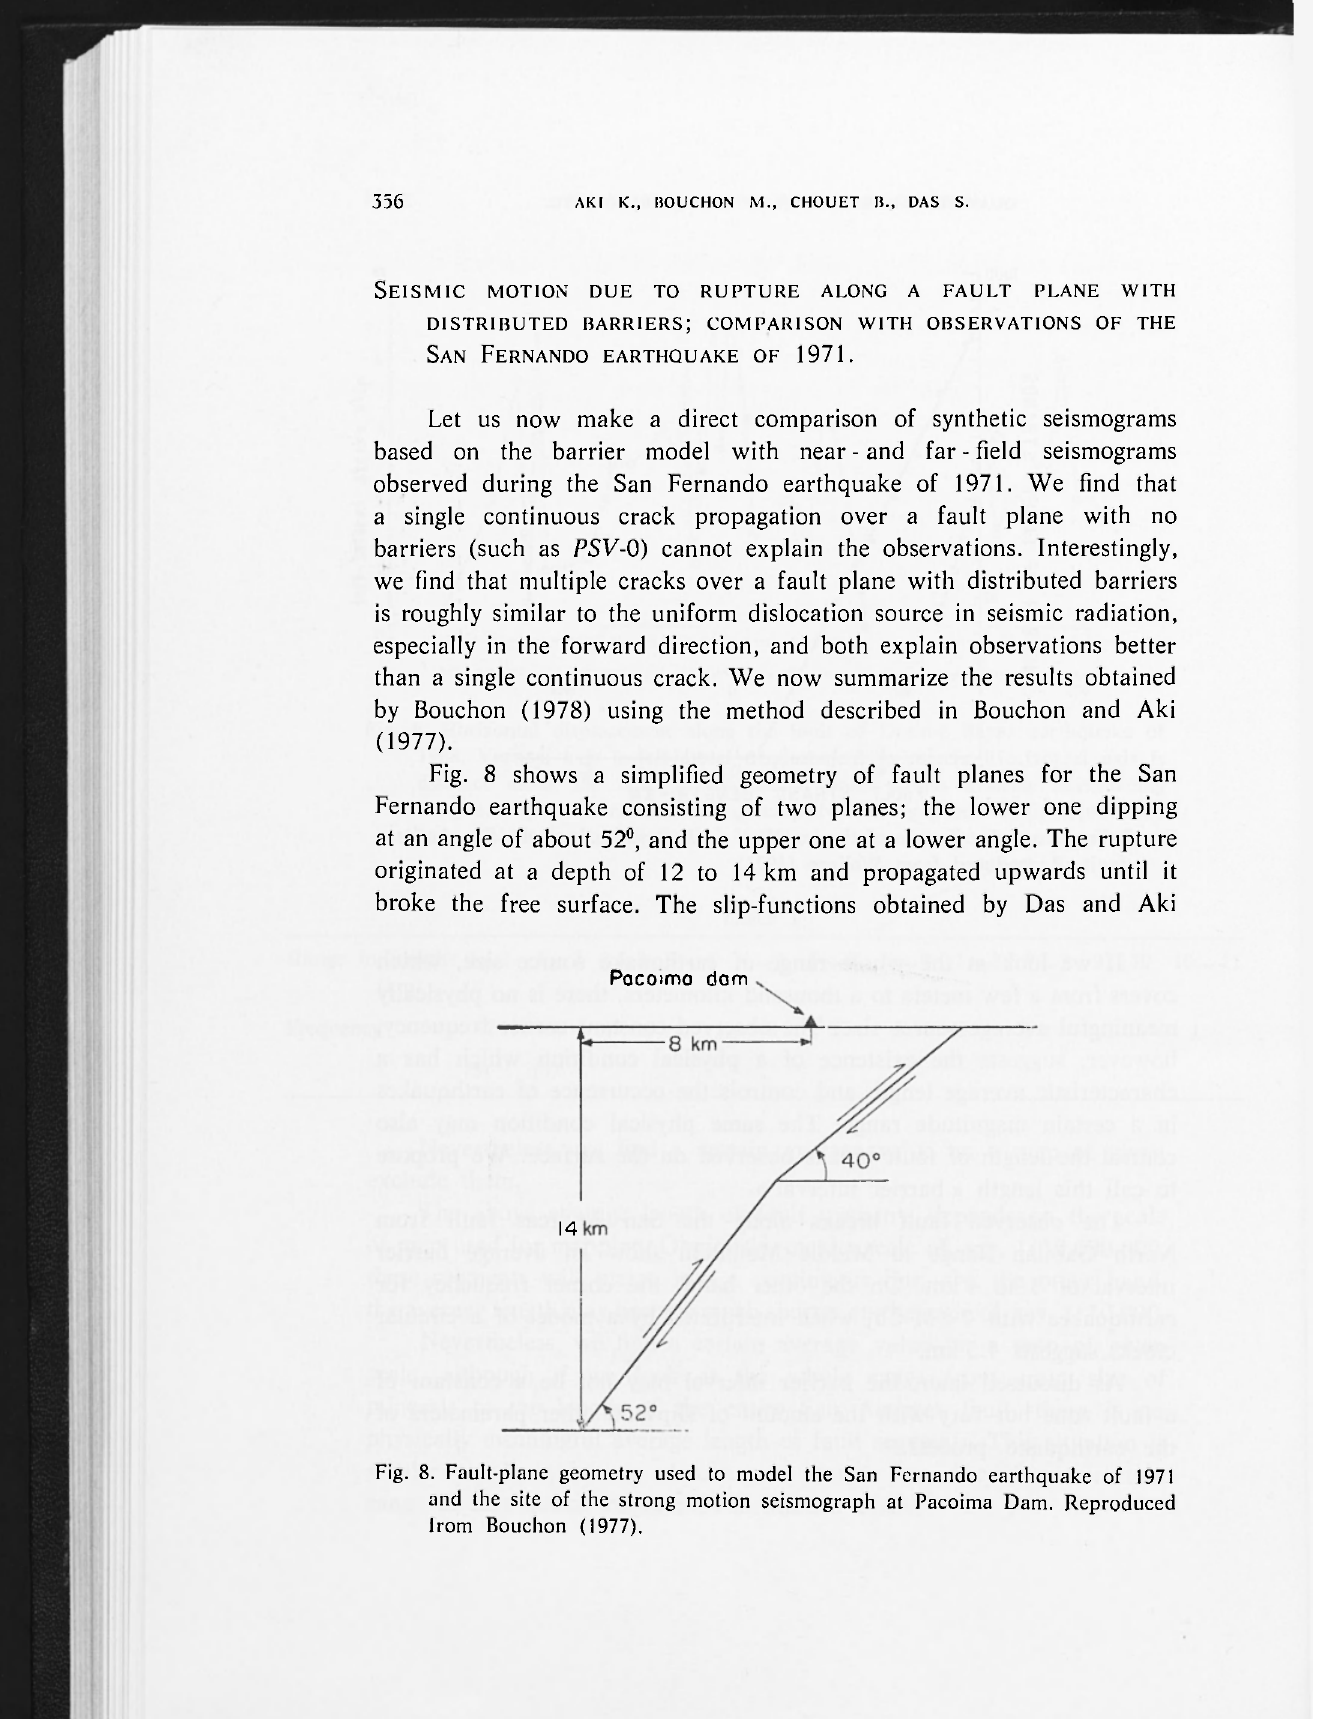
Fig. 8. Fault-plane geometry used to model the San Fernando earthquake of 1971 and the site of the strong motion seismograph at Pacoima Dam. Reproduced Irom Bouchon